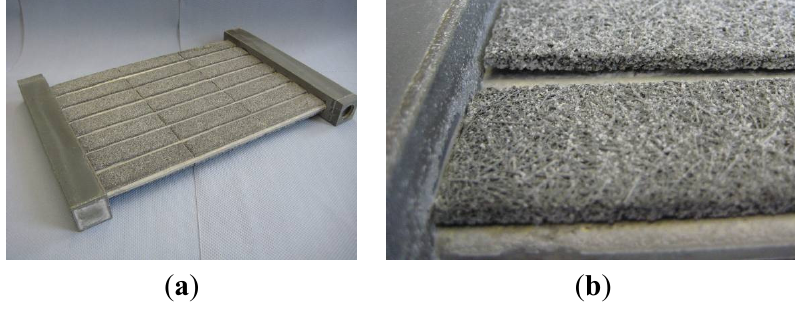
Figure 5. ( a ) Adsorption heat exchanger (AdHEX); ( b ) Detailed view: some parts of the fiber composite material still show poor contact to the surface of the heat